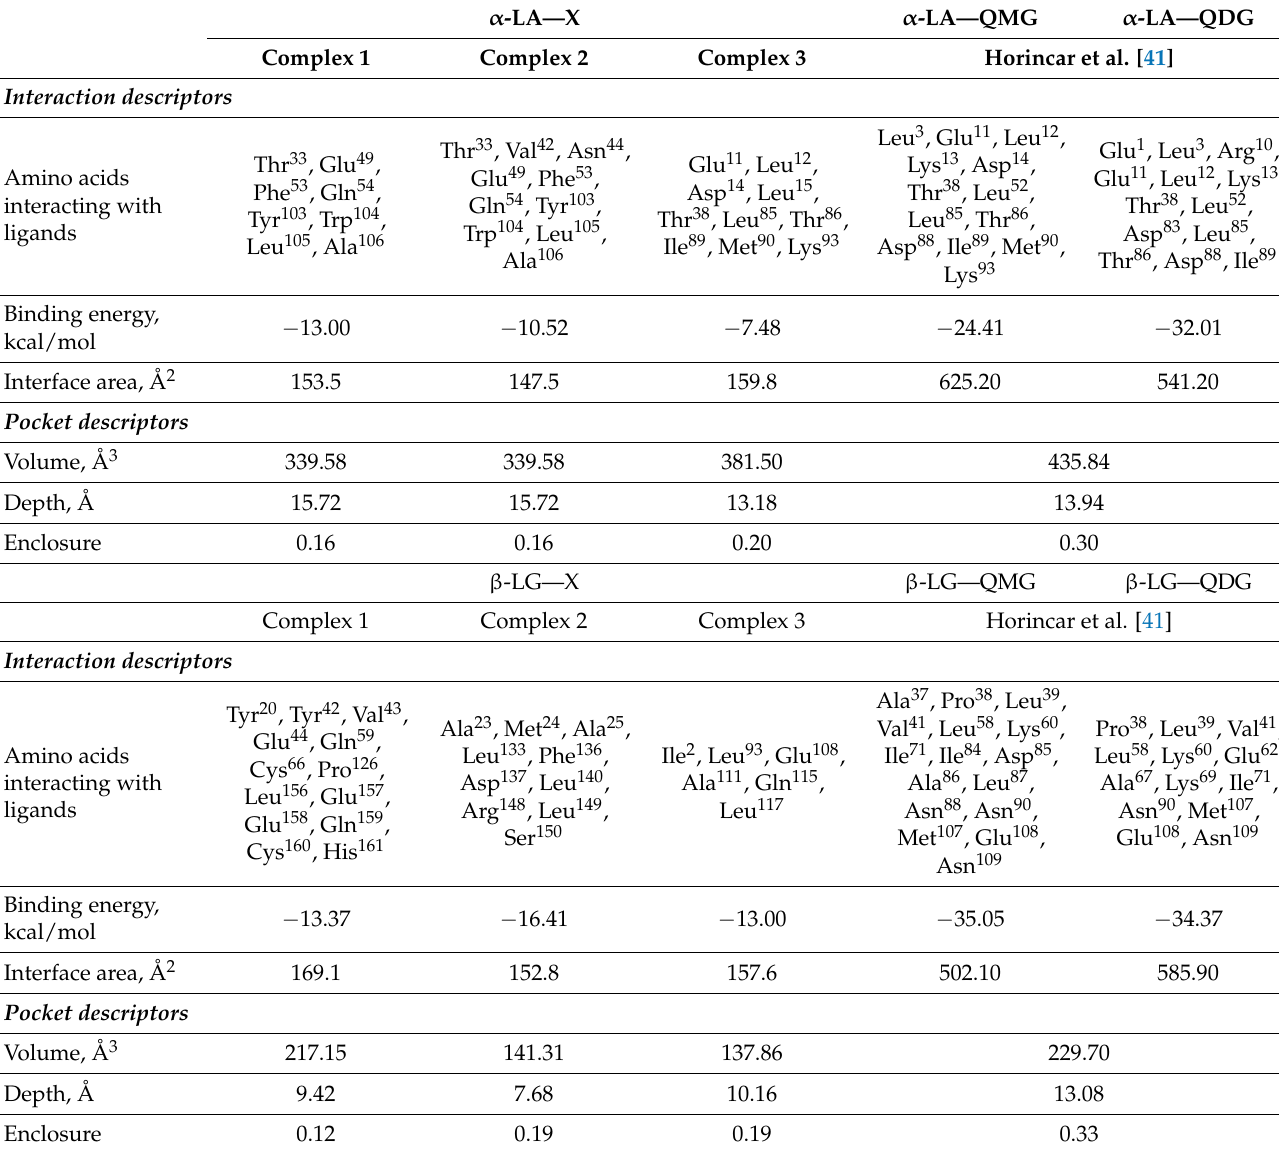
Table 1. Molecular details on the interactions between the main whey proteins ( α -lactalbumin ( α -LA) and β -lactoglobulin monomer ( β -LG)) equilibrated at 25 ◦ C, xylose (X) and the major flavonoids from onion skins (quercetin-4 (cid:48) - O